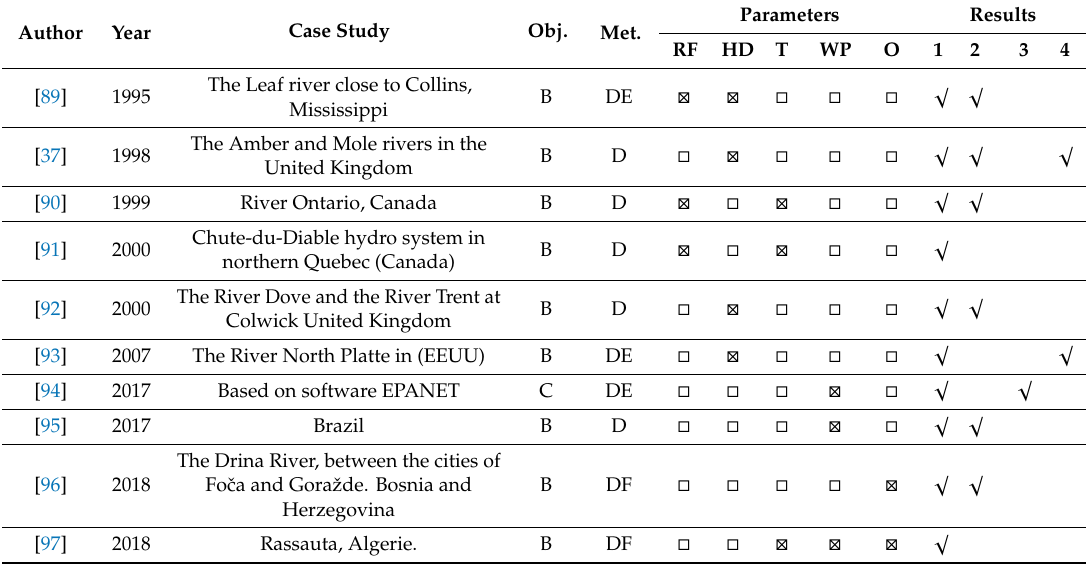
Table 4. Reviewed ANN studies on Hydraulic